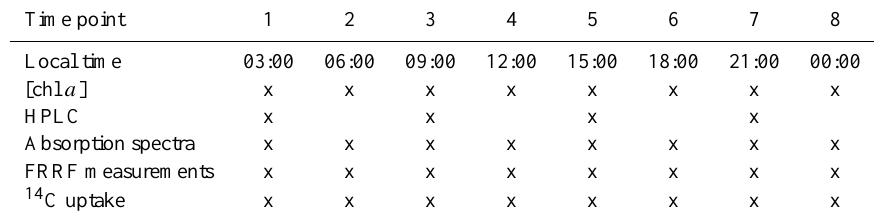
Table 1. Parameters measured at each time point during the diurnal experiment. Time point